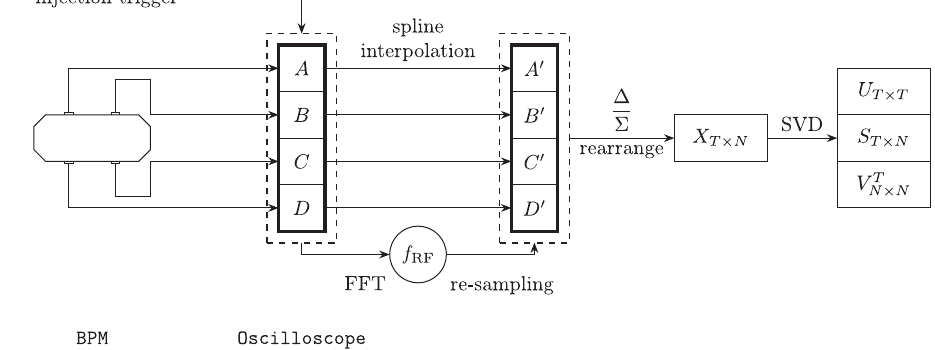
FIG. 3. Measurement scheme and data preparing. The oscilloscope is attached to the electrodes of the BPM and it fetches the original waveforms over 10000 turns right after the injection. After resampling the spline interpolation of the original waveform of each button at the frequency of f , the positions of each bunch is calculated and arranged for further rf